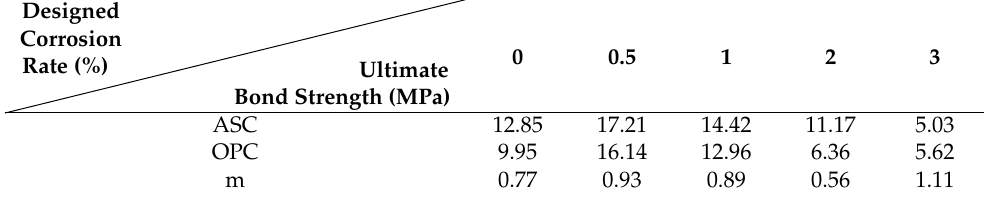
Table 9. Designed corrosion degree and average initial bond